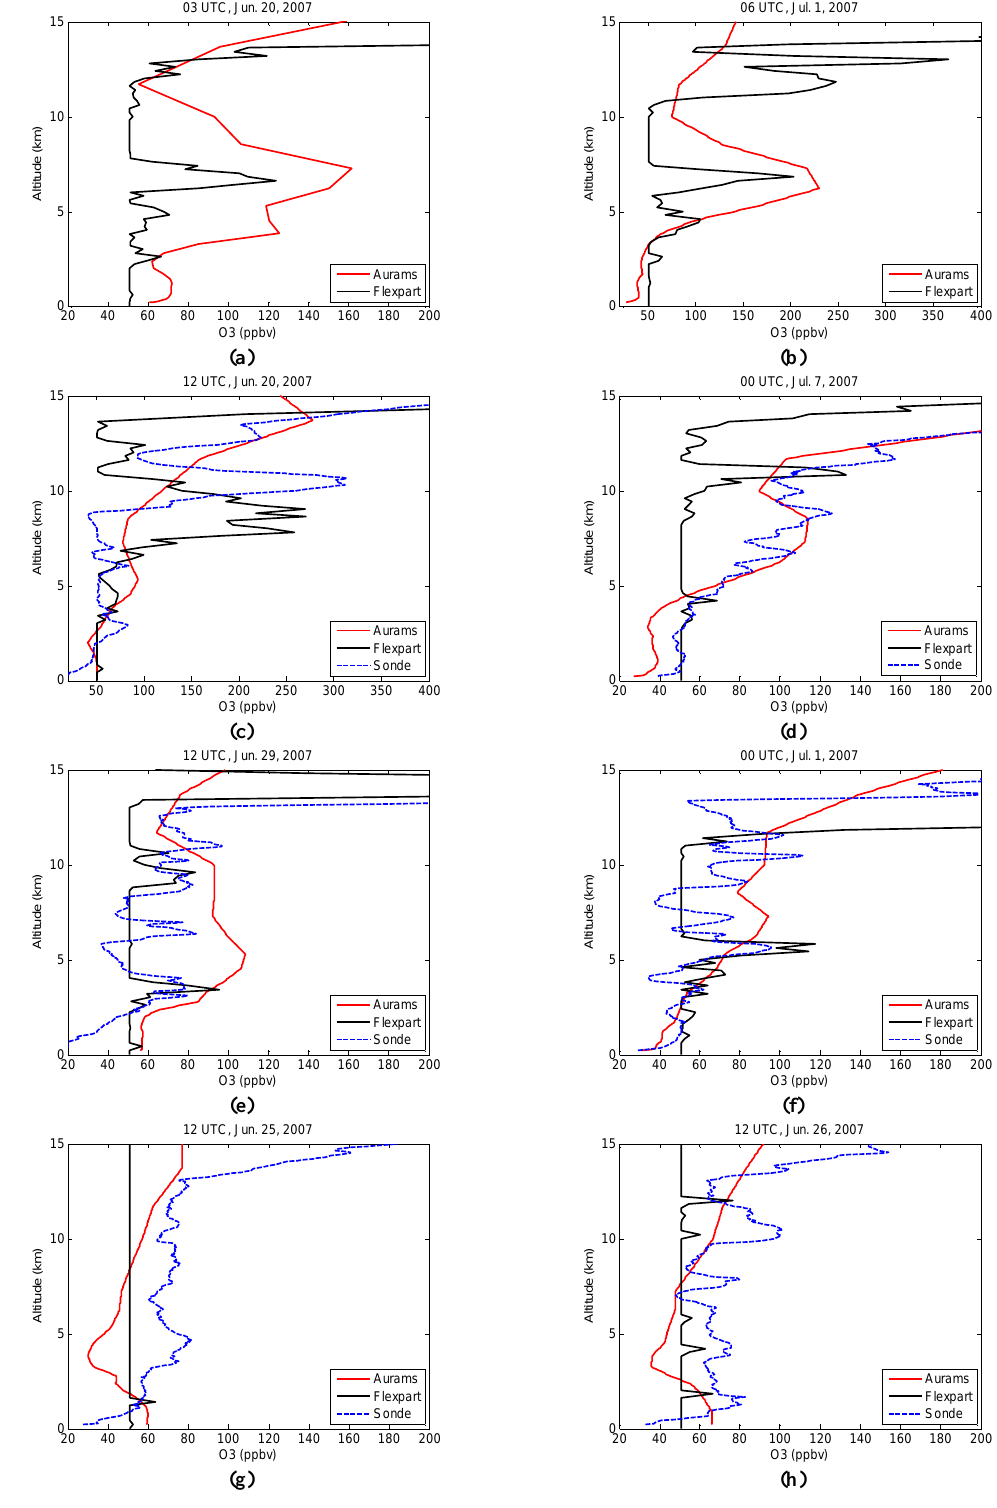
Figure 10: Comparison of ozone profiles extracted from GEM-FLEXPART and GEM-AURAMS simulations for Harrow, and ozonesonde profiles.